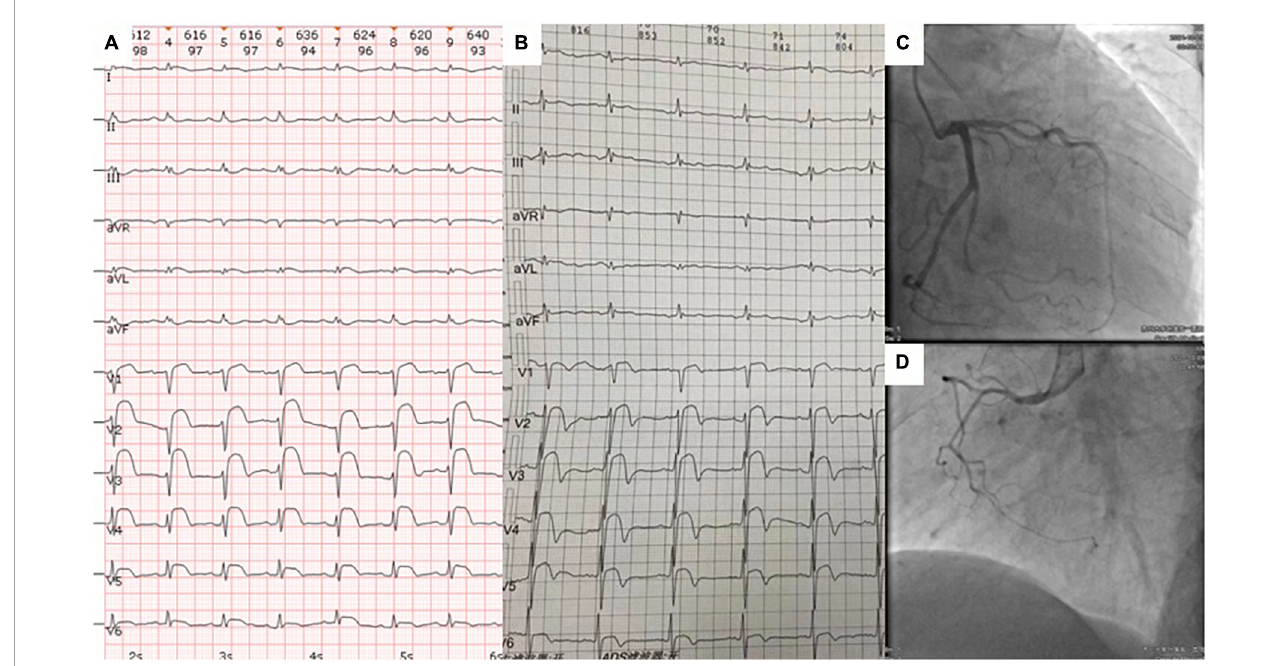
FIGURE1 The ECG at admission (A) and 4 months prior to admission (B) showed abnormal ST segment elevations in leads V1–V6 and low-voltage QRS complexes in limb leads. Coronary angiography revealed no significant stenosis in the right coronary, left anterior descending, and circumflex coronary arteries (C,D) .